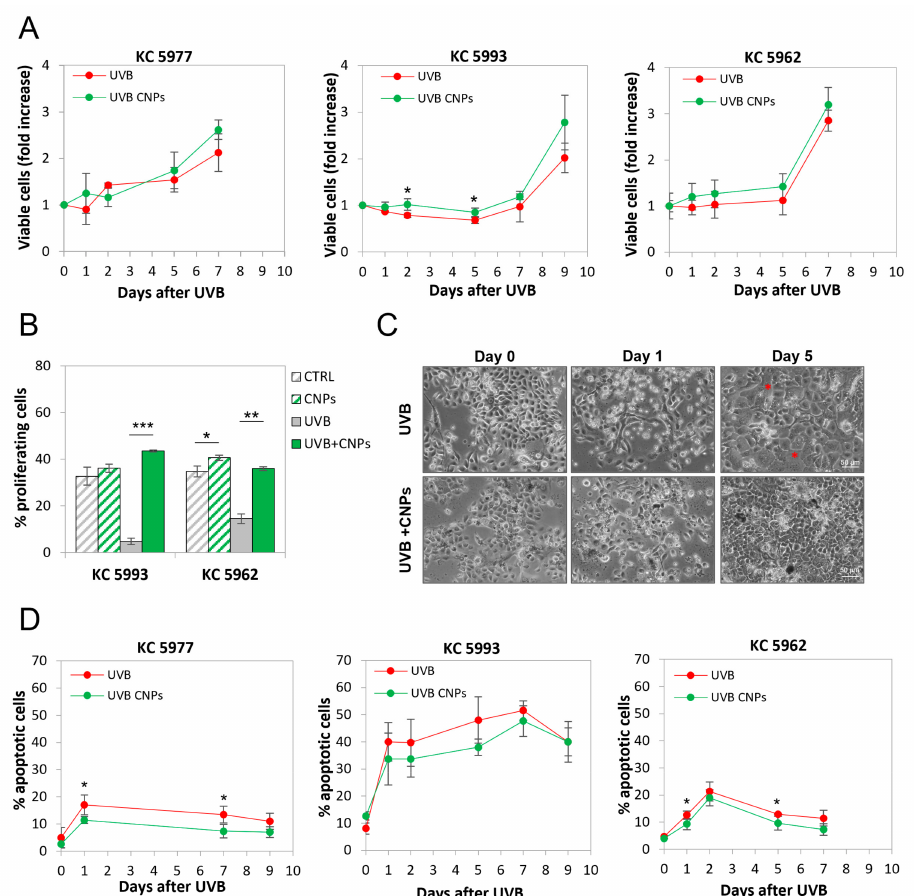
Figure 5. Nanoceria reduces UVB-induced cell loss in primary human keratinocytes from healthy donors. Keratinocytes (KC) from healthy donors (5977, 5993, 5962) were exposed to UVB ± nanoceria (CNPs) for 15 s and let recover for 7–9 days. ( A ) Kinetics of viable (trypan blue-excluding) cell number expressed as fold over day 0. Statistical significance was calculated via Student’s t -test. * p < 0.05, with respect to irradiated cells. ( B ) Nanoceria (CNPs) reduce UV-induced keratinocyte cytostasis. The fraction of binucleated cells at 48 h after UVB exposure in the presence of the cytokinase inhibitor cytochalasin B is shown. Statistical significance was calculated via Student’s t -test. * p < 0.05, ** p < 0.01 and *** p < 0.001. ( C ) Phase-contrast images of UVB-irradiated cells ± nanoceria (CNPs) at the indicated time points. A * indicates DNA damage-induced enlarged cells. ( D ) Time course of apoptotic cells after UVB exposure ± nanoceria (CNPs). Statistical significance was calculated via Student’s t -test. * p < 0.05 with respect to irradiated